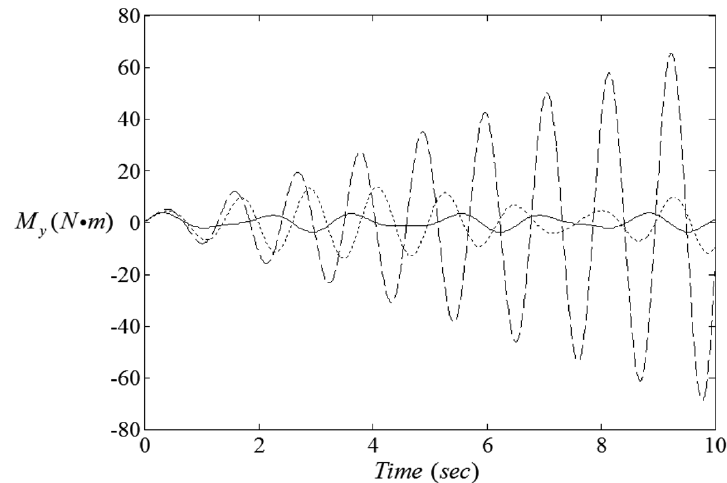
Fig. 10. The resultant hydrodynamic moment with the center of the bottom under the harmonic excitation for R 1 / R 2 = 0.6 and three different h 1 / R 2